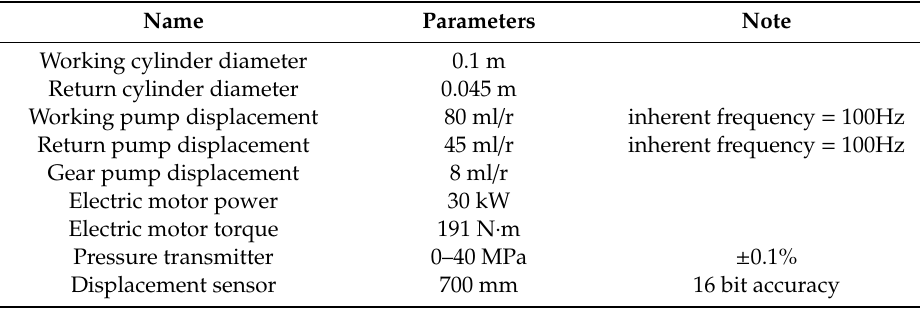
Table 3. The hydraulic system parameters of the 0.6MN forging press.